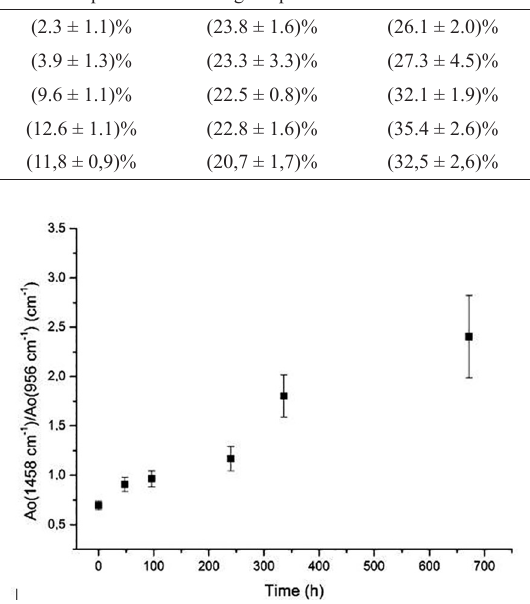
Figure 6: TG isothermal curves of mass loss in function of time, at 260°C.